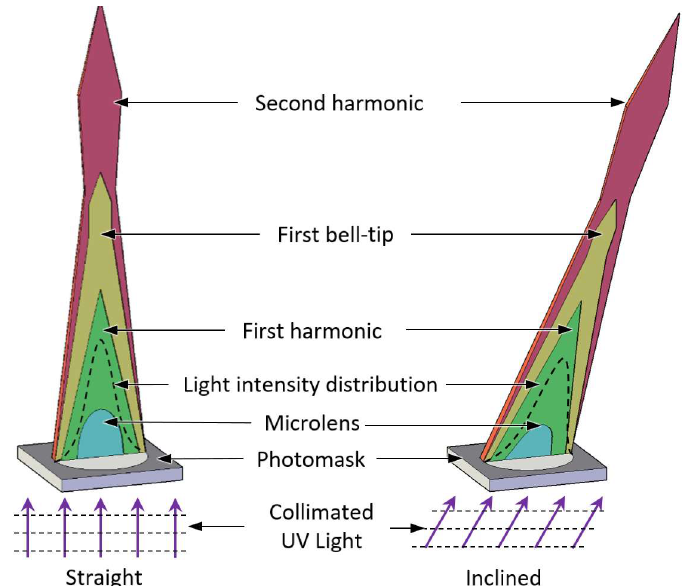
Figure 1. Four transition phases of the straight and inclined microneedles.